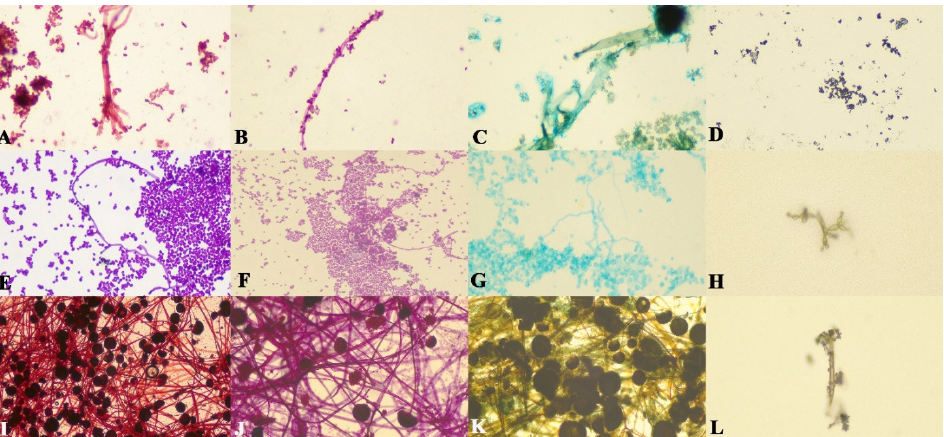
8.77 μm to 17.86 μm. The pseudohyphae were non-septate and ranged in width from 3.80 μm to 17.75 μm. The spores of Rhizopus oryzae were angular–ovoid in shape with a diam- eter ranging from 15.96 μm to 28.25 μm. The hyphae were non-septate and branching at right angles, with widths ranging from 2.43 μm to 17.16 μm. The fruiting bodies of Rhizo- pus were the largest, ranging in diameter from 98.67 μm to 124.80 μm, respectively. (Fig- ure 2) The differences in size between the organisms were found to be statistically signif- icant (Table 8).